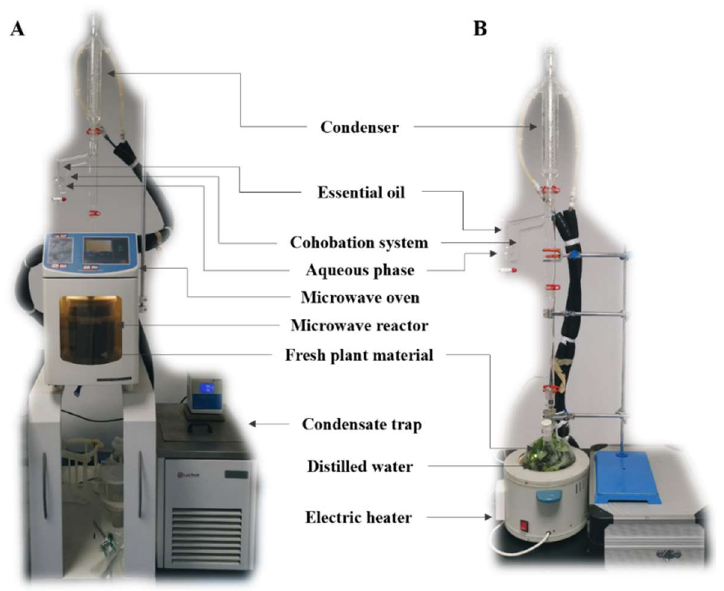
Figure 1. Apparatus for the ( A ) solvent-free microwave extraction and ( B ) conventional hydrodis- tillation.